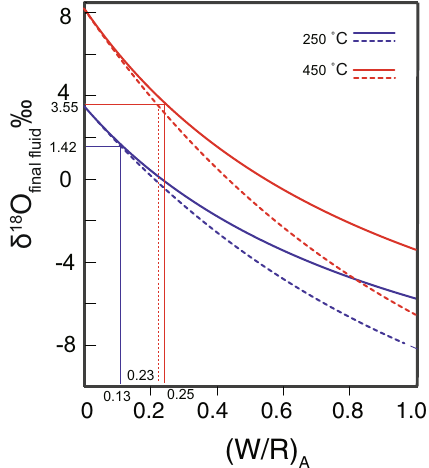
Figure 4. ( a ) Oxygen isotopic compositions of fluid and rock reacted with volcanoclastic rocks and meteoric water. Dashed and solid lines for an open and closed system respectively. The figure illustrates that reaction results in the fluid to crystalize garnet with δ 18 O of 1‰ at associated water-rock ratios under a temperature of 250~450 °C. The marked (W/R) A from 0.13, 0.23, and 0.25 are water/rock atomic ratios, and the calculated water/rock mass ratio are 6.5%, 11.5%, and 12.5%. The detailed calculation procedures could be found in the Supplementary Dataset